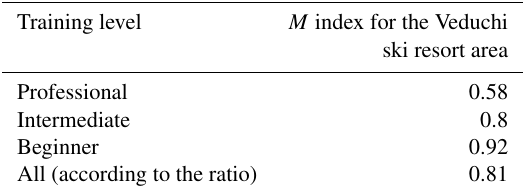
Table 7. The area of the dangerous zone compared to the whole area of the avalanche catchment zone for each training